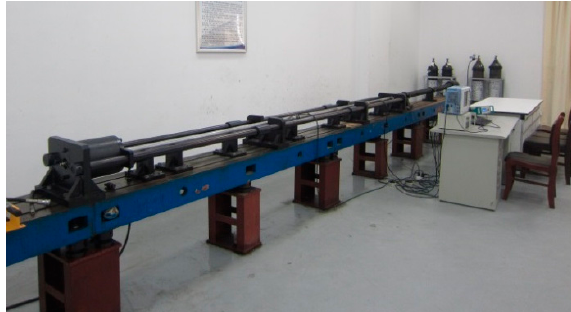
Figure 4. Split Hopkinson pressure bar test apparatus.